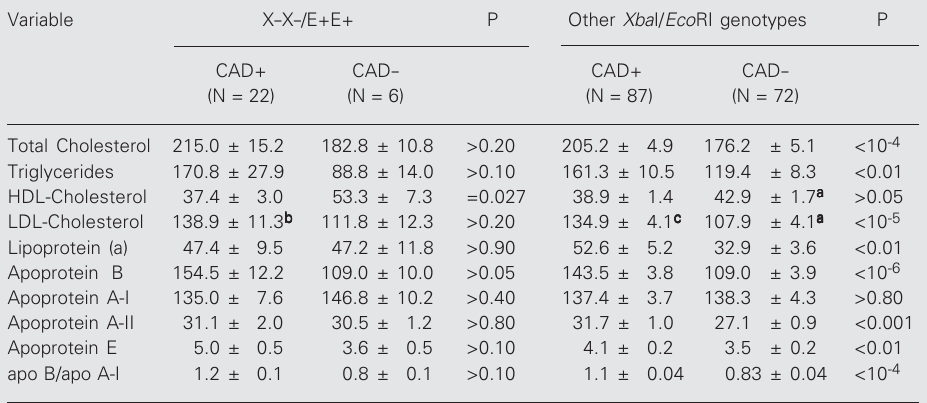
Table 5. Serum levels of lipids, lipoproteins, apolipoproteins (apo) and of the apo B/apo A-I ratio of the X-X-/ E+E+ genotype and of the other Xba I/ Eco RI genotypes in the CAD+ and CAD- groups, as compared by the Student t